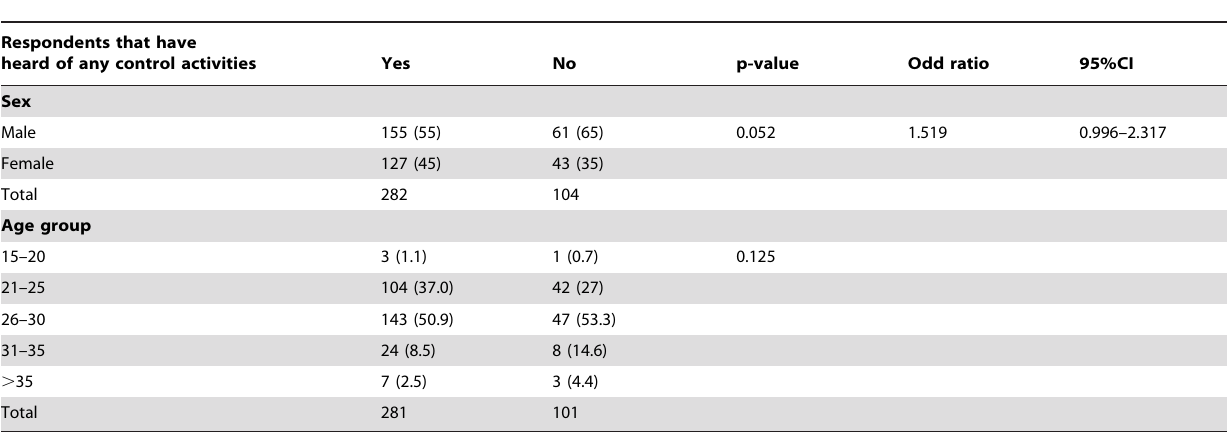
Table 4. Knowledge of any NTD control activities by sex and